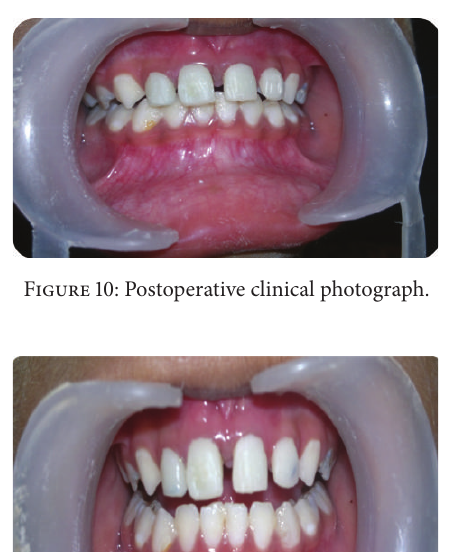
Figure 7: Fabrication of post core: bend the free end upwards and cut the excess to form an anchor shape.